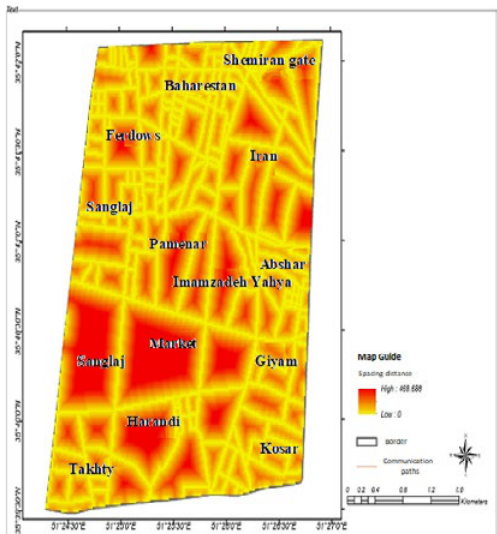
Fig. 10: The fuzzy layer of the distance from communication roads of the District Fig. 9: ‐ Distance from communication roads of the District